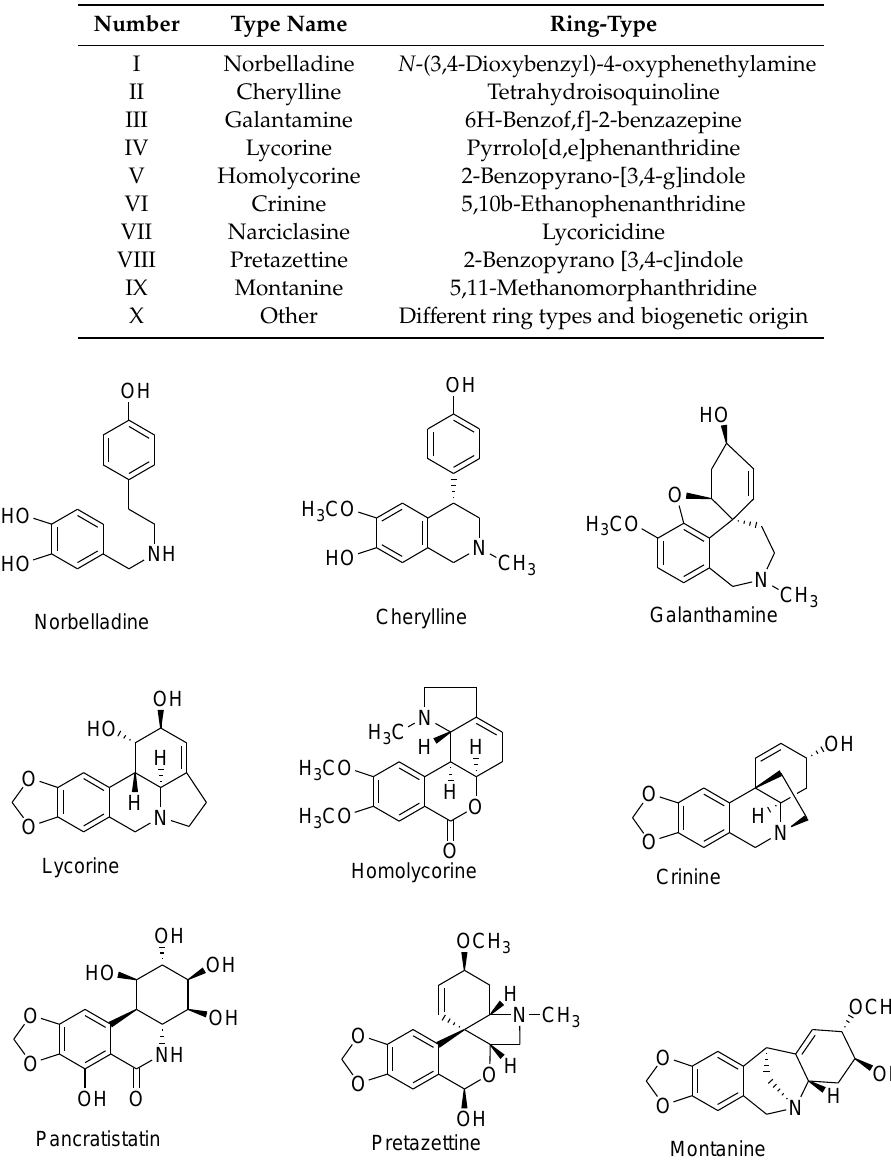
Table 1. Main types of Amaryllidaceae alkaloids grouped according to their ring type and biosynthetic origin.